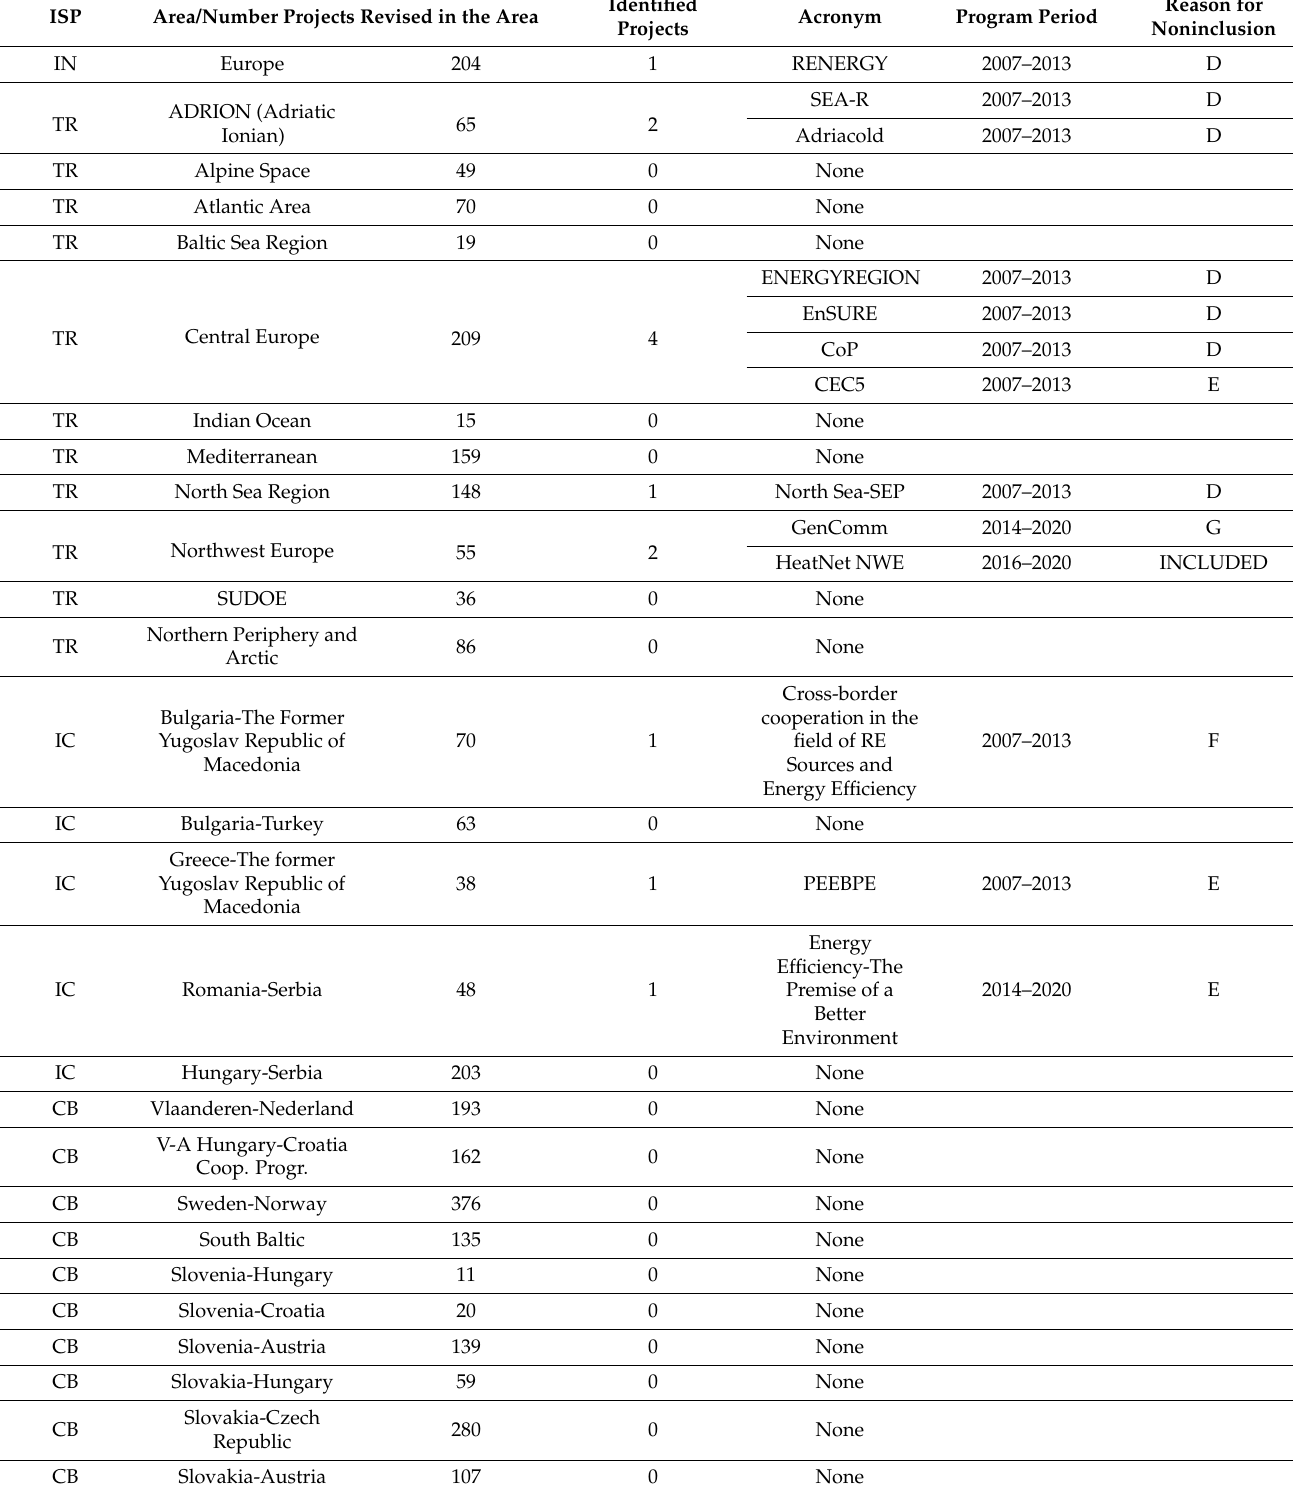
Table 2. Results for projects corresponding to the Interreg Program. The first column corresponds to the Interreg Sub- Program (ISP) to which the geographic area of the second column belongs: interregional (IN), transnational (TR), IPA CBC (IC) and cross Border